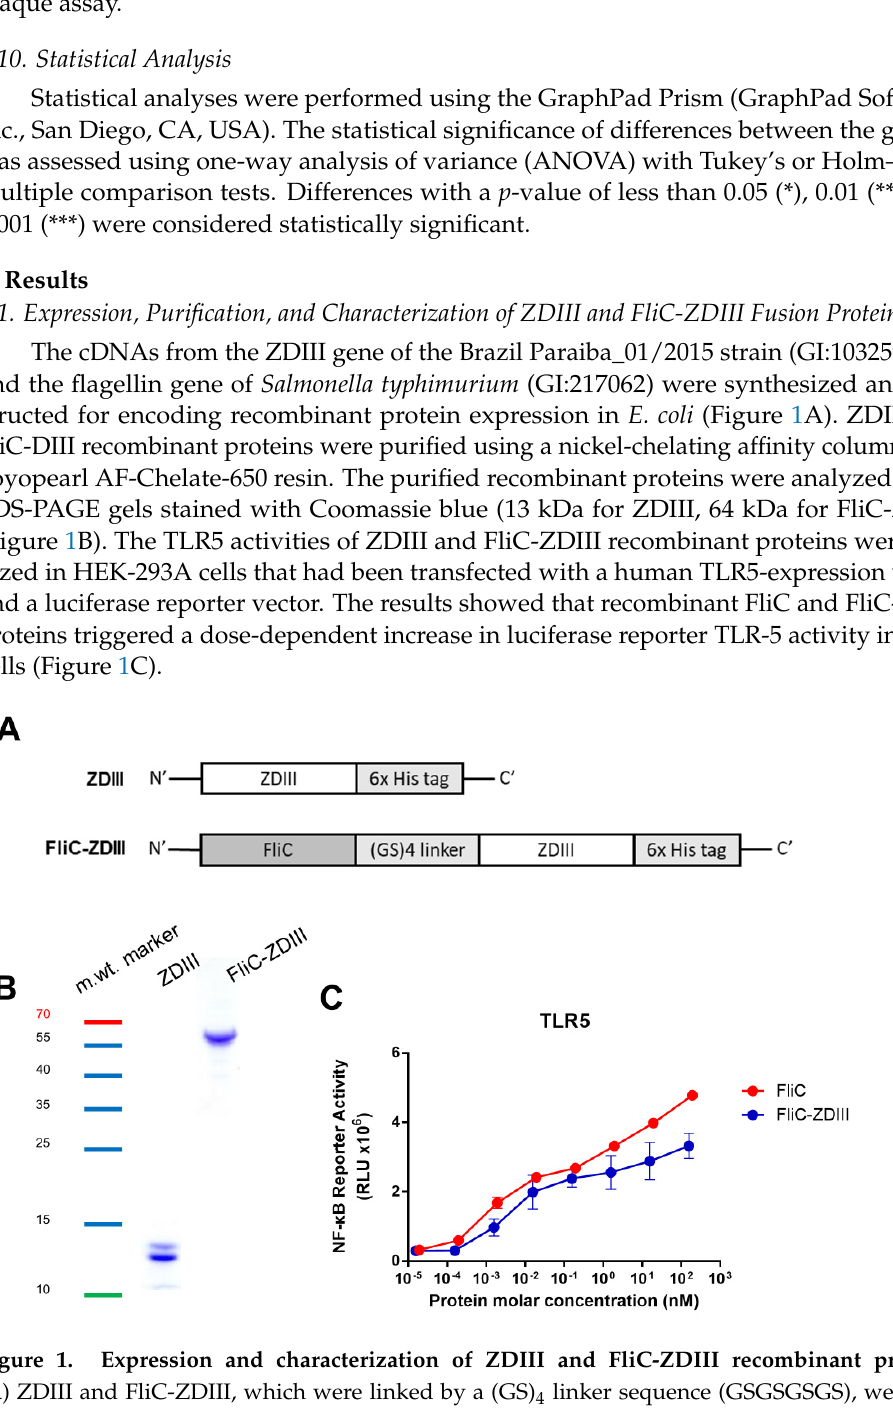
linker sequence (GSGSGSGS), were constructed 4